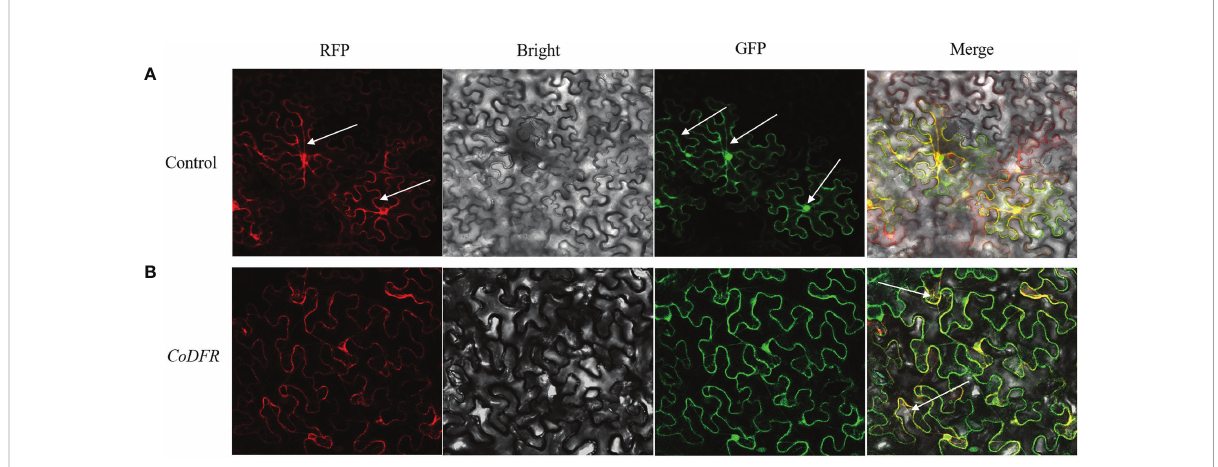
FIGURE 4 Subcellular localization of CoDFR. (A) Control, EV-GFP, and endoplasmic reticulum marker (35S: EV-GFP). (B) CoDFR, 35S: CoDFR-GFP and endoplasmic reticulum maker fusion proteins (35S: CoDFR-GFP). The white arrow shows the location of the description.